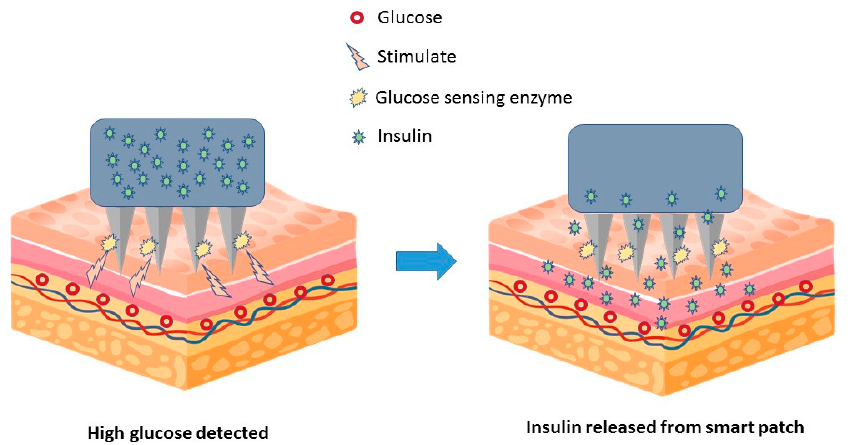
Figure 4. The microneedle-based patch painlessly penetrates into the skin layer. The smart patch contains insulin and the glucose-sensing enzyme glucose oxidase, which converts glucose into gluconate. Higher glucose oxidase activity in response to increased glucose triggers nanoparticle degradation and insulin release.